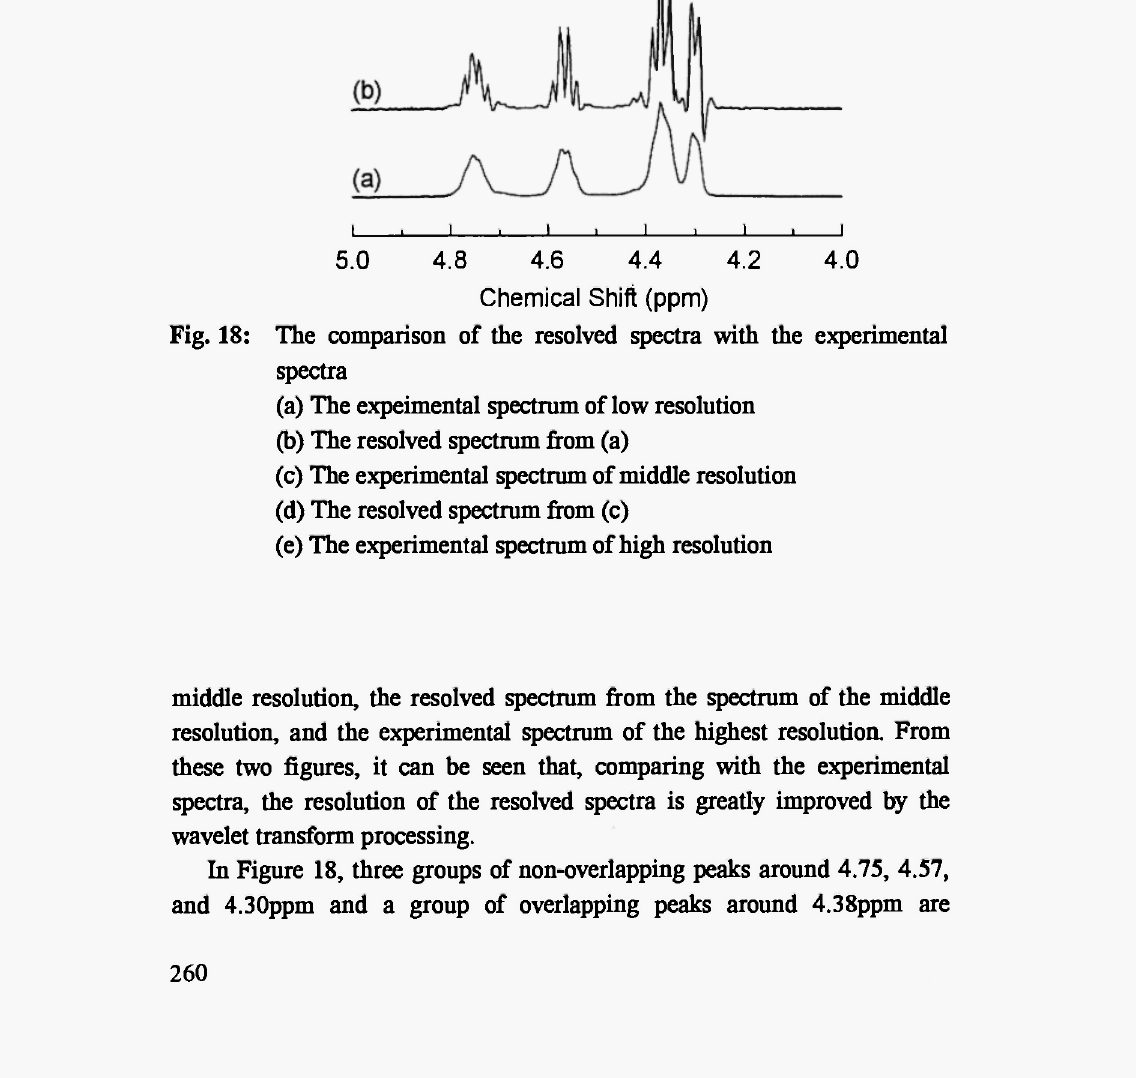
Fig. 18: The comparison of the resolved spectra with the experimental